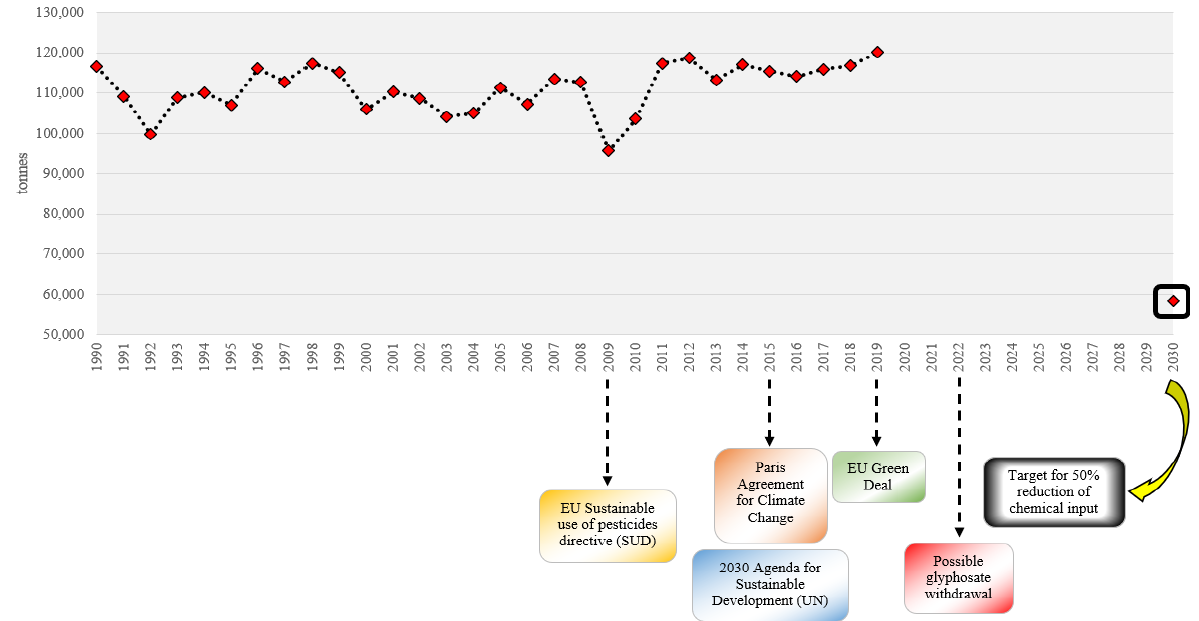
Figure 1. Total herbicide use in the EU 27 between 1990–2019 and the important milestones and targets for chemical pesticide reduction by 50% by 2030 (FAOSTAT, https://www.fao.org/faostat/en/#data/RP, accessed on 15 January 2022).